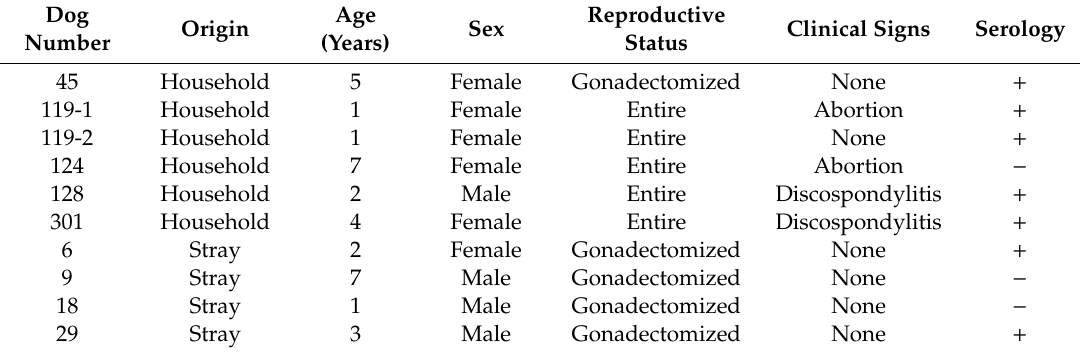
Table 1. Epidemiologic characteristics of the bacteriologically and qPCR-confirmed infected